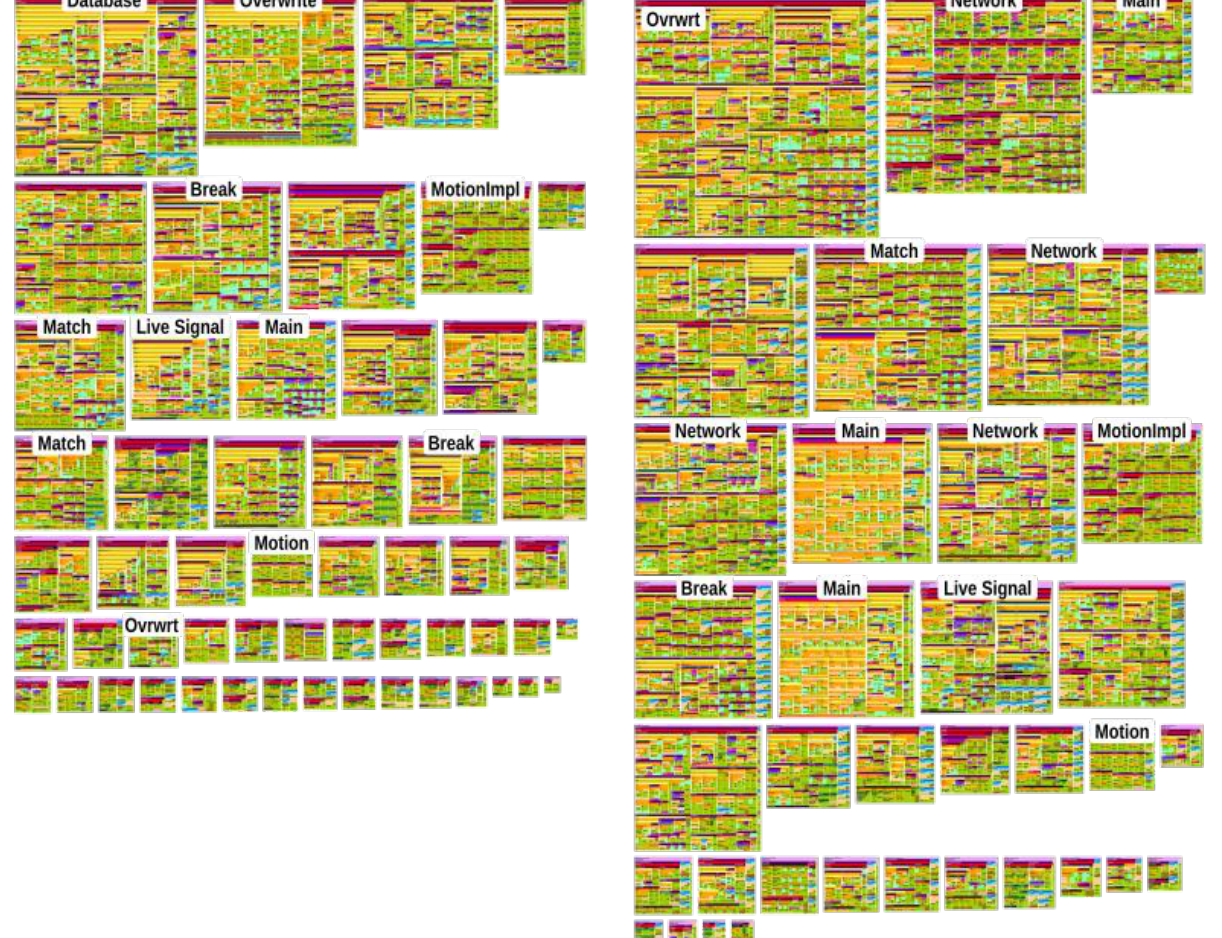
Figure 2 | Left: Code base of Writing Machine. Right: Code base of Wr_t_ng